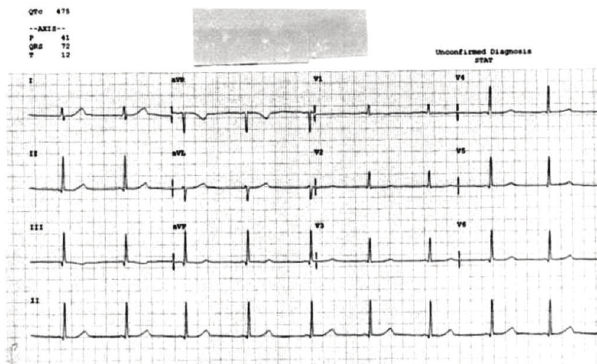
Figure 2: Electrocardiogram obtained on hospital day number 7. Note the persistently prolonged QT interval of 475 ms.